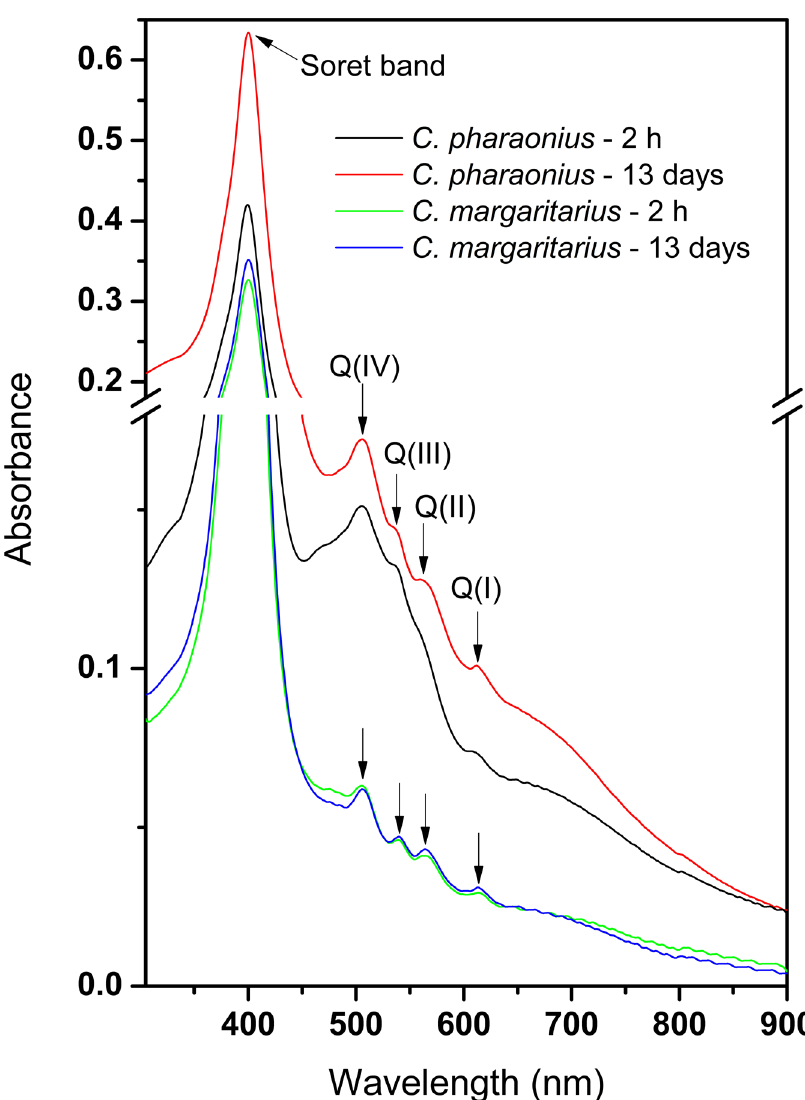
Fig 5. UV-visible absorption spectra of the Na-EDTA aqueous extracts from C . margaritarius A (specimen #5) and C . pharaonius (specimen #5) collected at 2 hours and 13 days after extraction. Positions of λ max (Soret band) and Q bands Q(I) – Q(IV) are